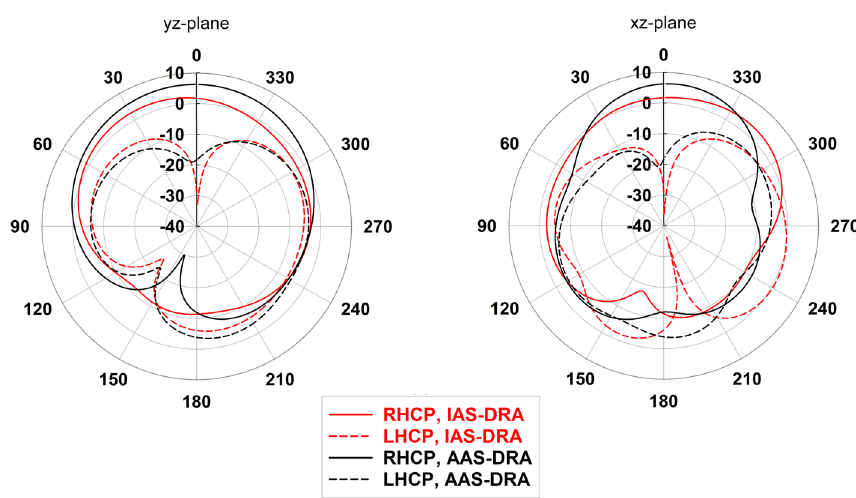
Figure 6. Simulated radiation patterns of the IAS-DRA and the AAS-DRA in the xz -plane (left) and yz -plane (right) at 5.5